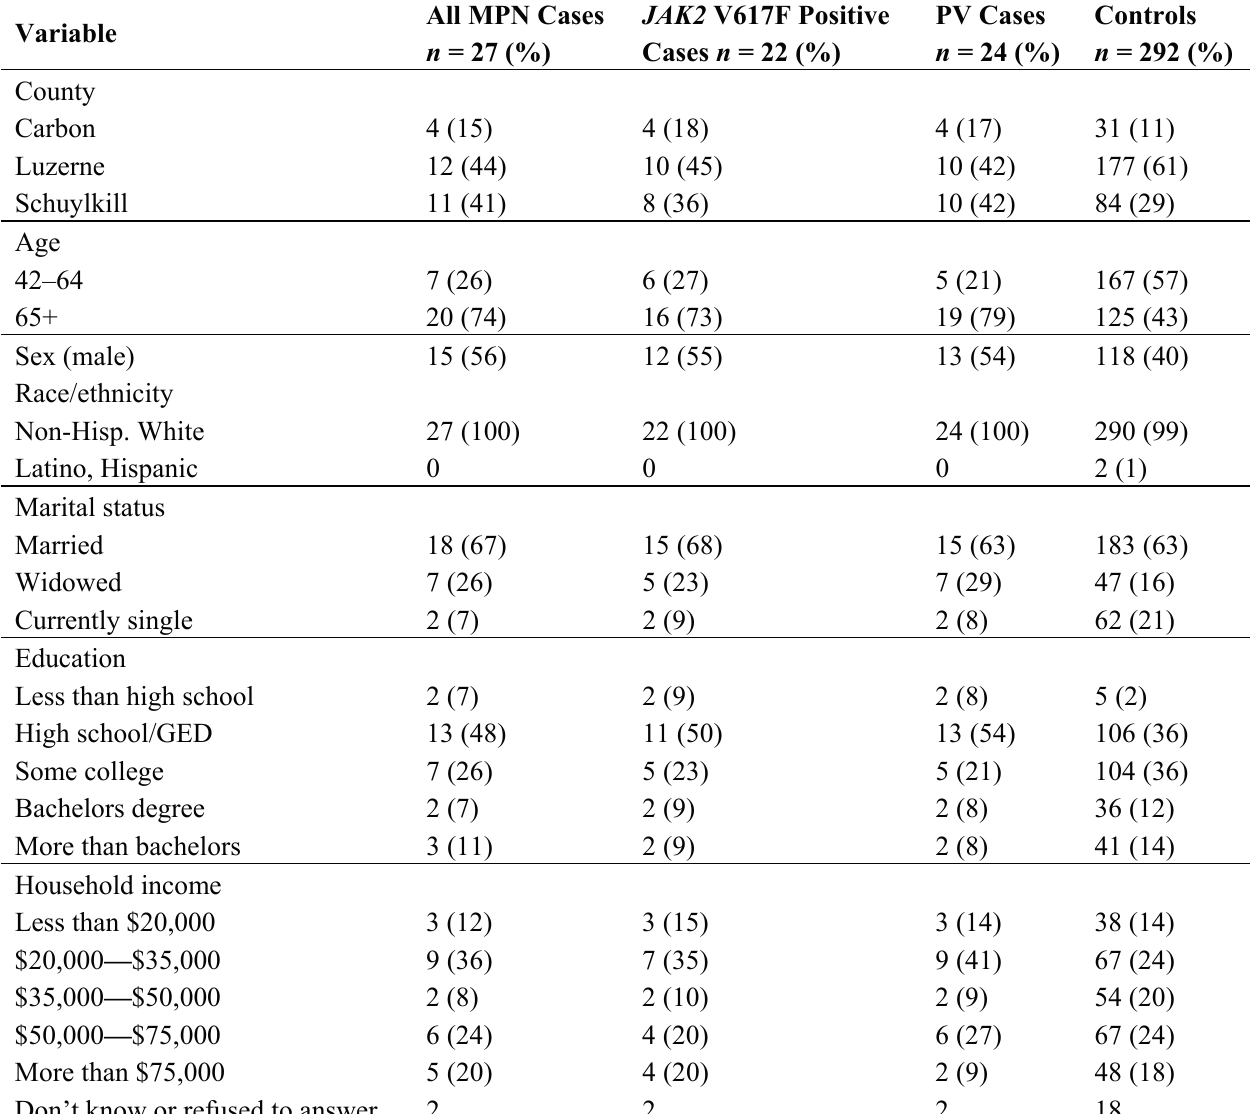
Table 2. Demographic characteristics of cases and